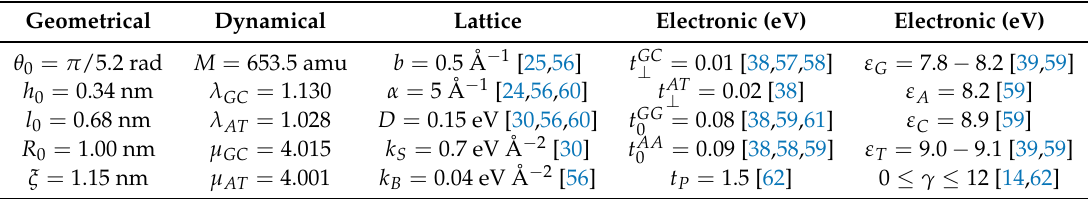
Table 1. Geometrical, dynamical, lattice model, and electronic model parameters adopted in the dsDNA homopolymer model studied in this work. The same effective Morse potential is used to describe H-bonding in both GC and AT bps. The spring constant k B is difficult to estimate, and different possible values, ranging from 0.04 to 0.5 eV Å − 2 , have been reported in the literature [50–55]. Geometrical Dynamical Lattice